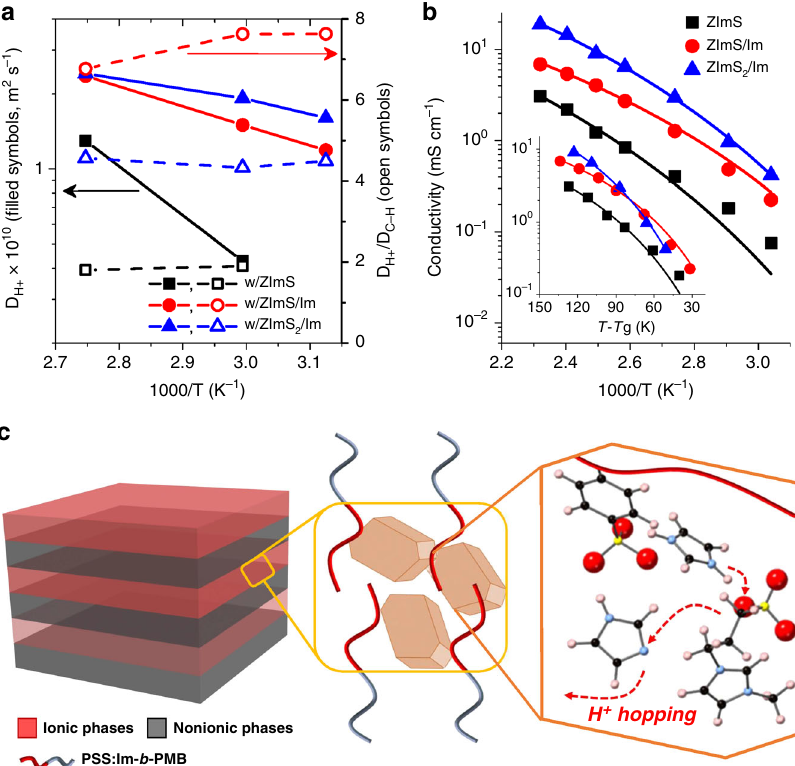
Fig. 5 Proton transport properties. a Proton diffusion coef fi cients, b ionic conductivities, obtained for PSS:Im- b -PMB comprising additives, measured at different temperatures. In a and b the role of ionic crystals in determining the ion transport properties of single-ion polymers was clearly shown. c Schematics depicting dominant proton hopping mechanisms in PSS:Im- b -PMB containing